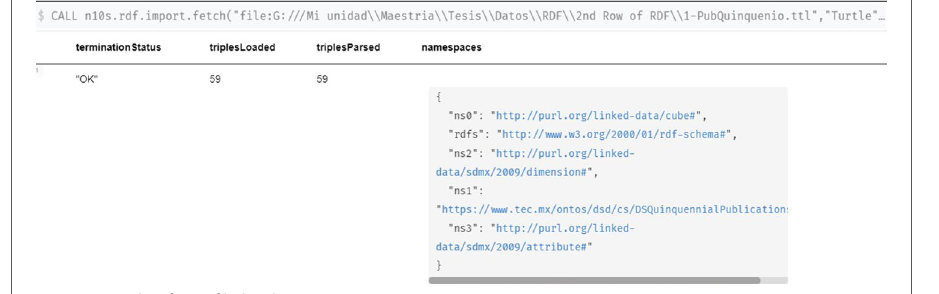
Fig. 7 Example of RDF file load to Neo4j